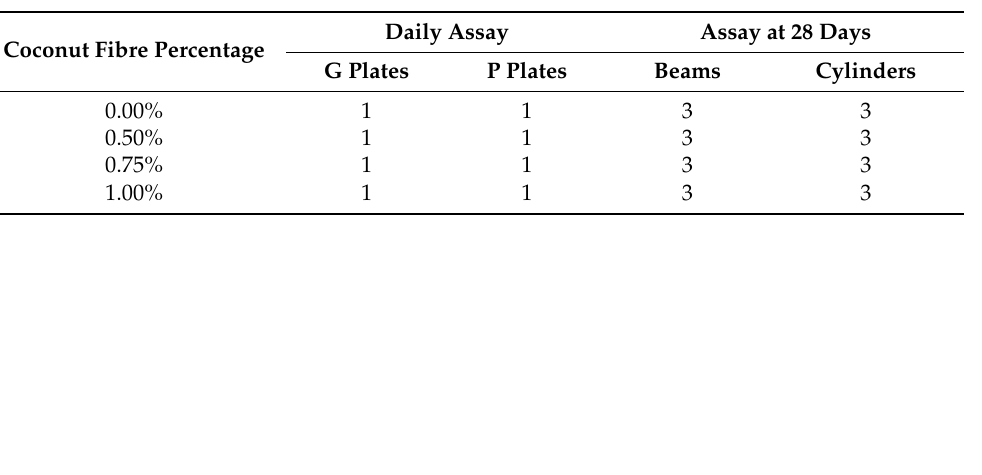
Table 3. Number of specimens contemplated in the